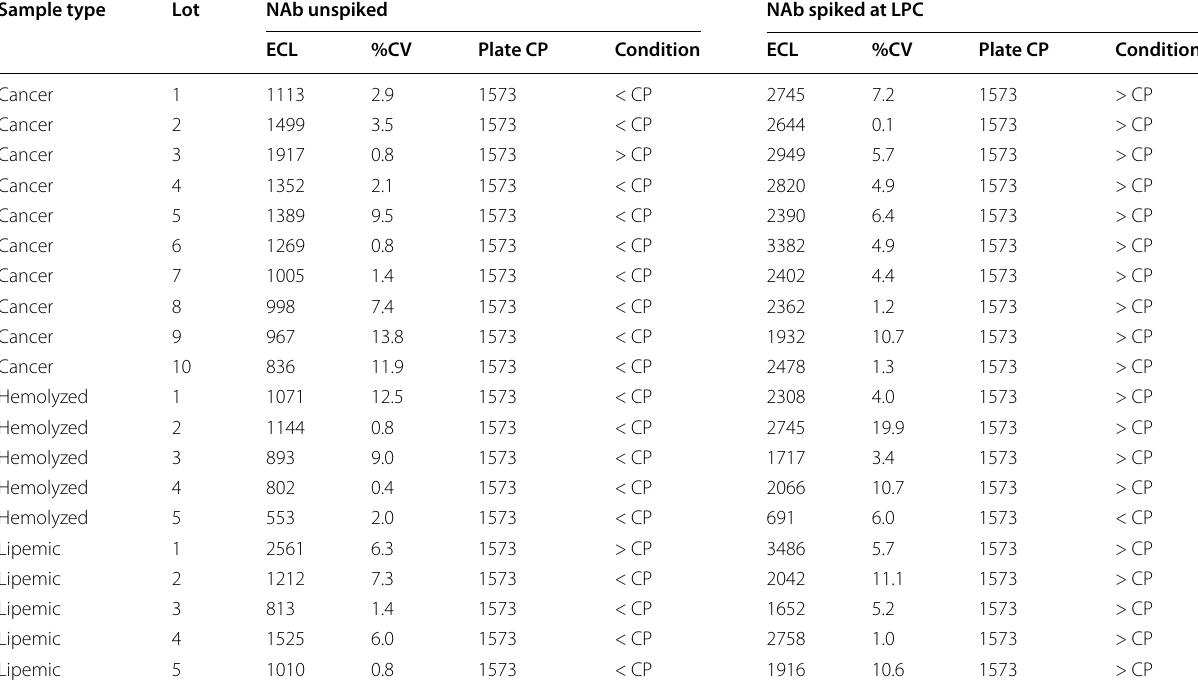
CP , cut point; %CV , coefficient of variation; ECL , electrochemiluminescence readout; LPC , low-positive control; NAb , neutralizing antibody